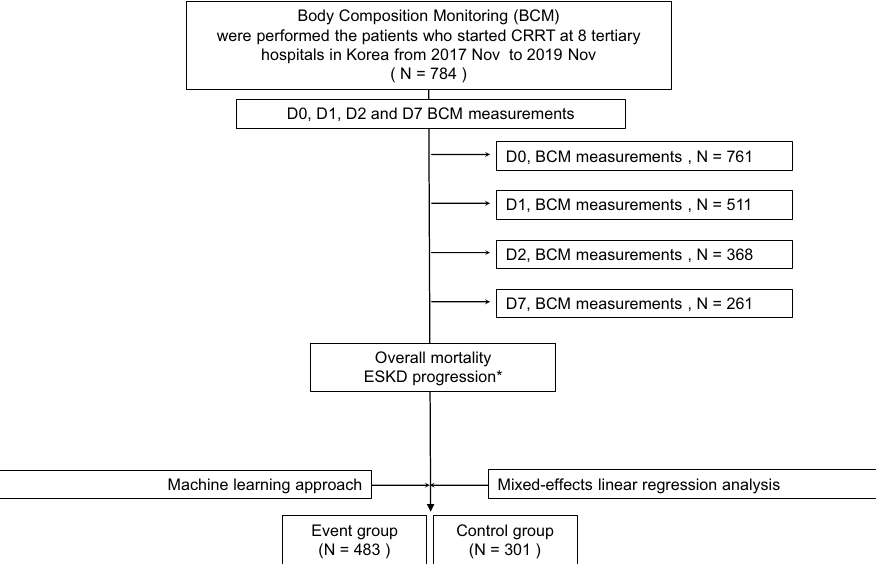
Figure 1. Study flowchart. End-stage kidney disease is defined by the maintenance of dialysis at 3 months after CRRT initiation. Body composition monitoring is performed using